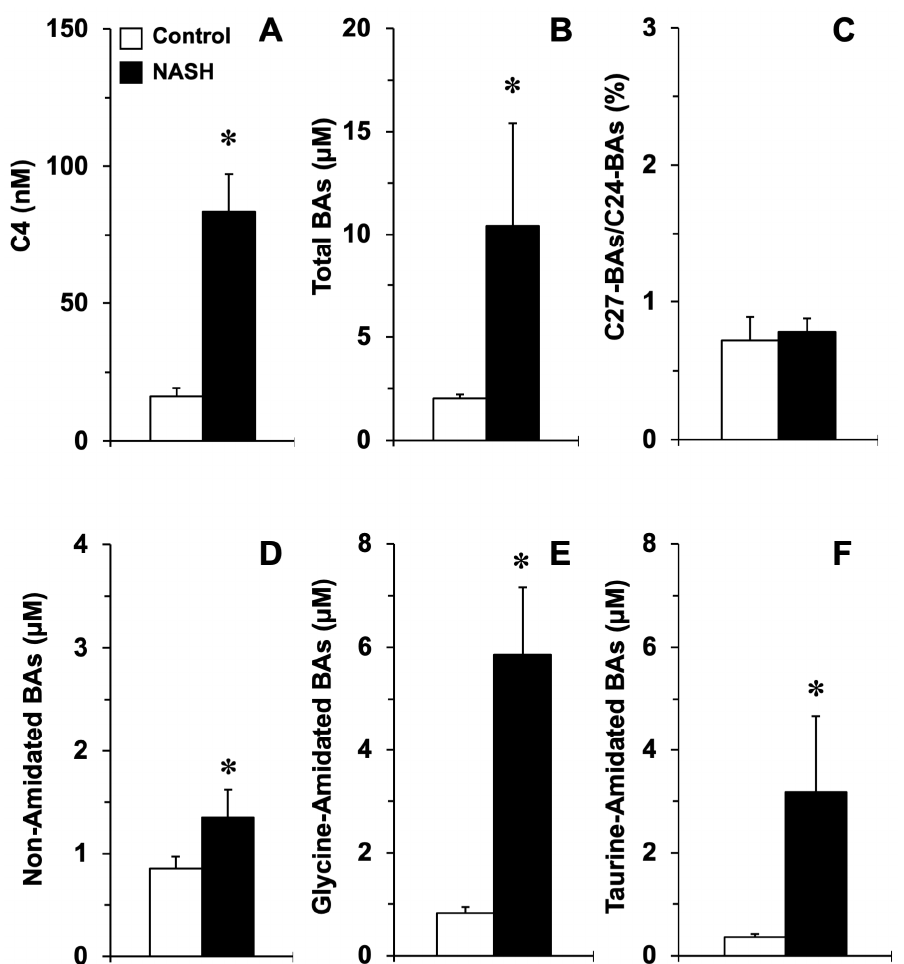
Figure 8. Concentrations of the bile acid (BA) precursor 7 α -hydroxy-4-cholesten-3-one (C4) ( A ), total BAs ( B ), the proportion of C27-BAs ( C ), unconjugated BAs ( D ), and BAs amidated with glycine ( E ), or taurine ( F ) in the serum of healthy subjects (Control, n = 27) and patients with non-alcoholic steatohepatitis (NASH grade F3-F4; n = 29). Serum BA species and C4 were measured by HPLC- MS/MS. *, p < 0.05, as compared to Control by the Student’s unpaired t -test.